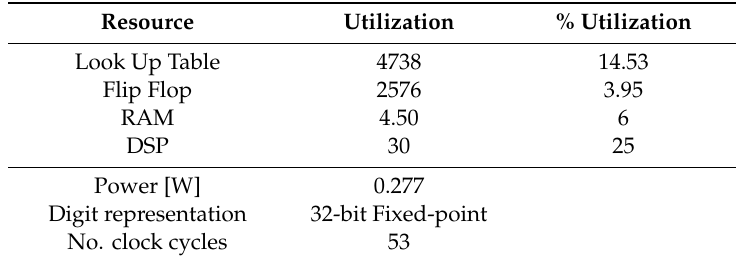
Table 9. Indicative values of the utilization and power required for the attitude determination algorithm.